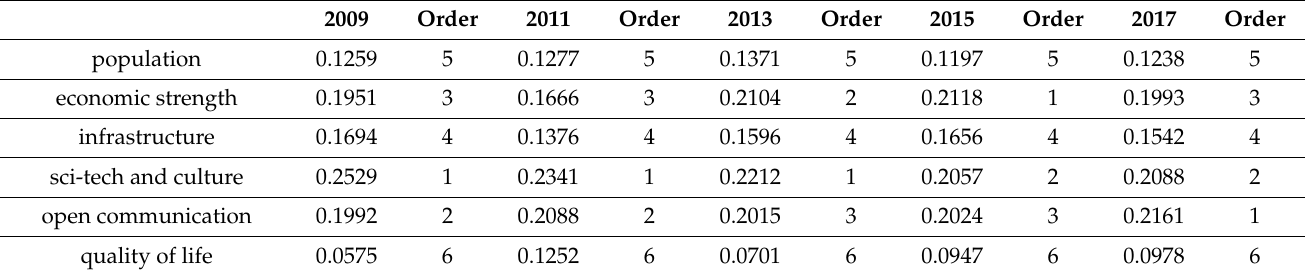
Table 3. The first-level indicators’ entropy weights from 2009 to